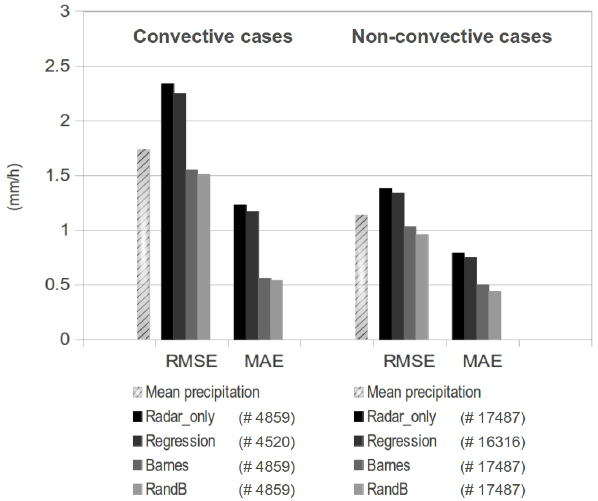
Fig. 6. Statistical verification results for the four different accumu- lation methods split into two different air-mass stability situations; left panel: convective cases (i.e. thunderstorms) and right panel: non-convective cases (i.e. warm fronts). The symbol # indicates the number of observations used in the calculations. The mean precipi- tation for each case, calculated from rain-gauge values, is included as a dashed